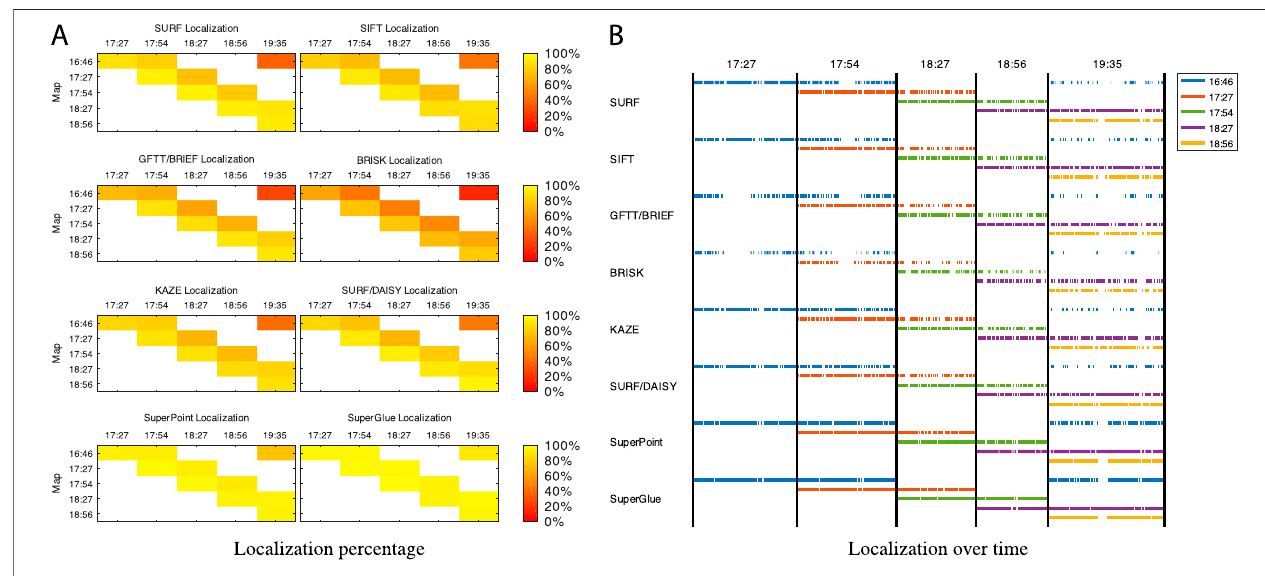
FIGURE 7 | Re-localization performance of the last fi ve mapping sessions ( x -axis) over preceding mapping sessions ( y -axis), in relation to visual features used: (A) re-localization percentage; (B) re-localization over time.